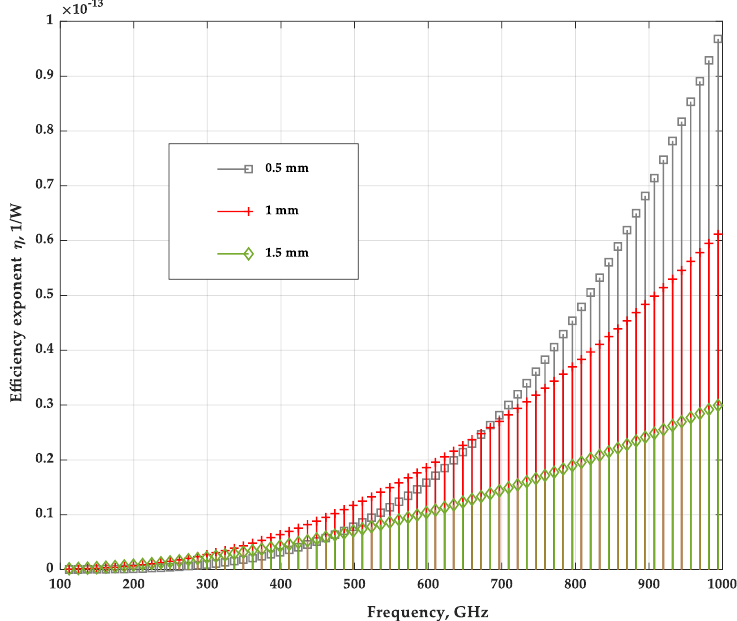
Figure 4. Dependence of the efficiency exponent η of a radio vortex beam on the difference frequency f of laser beams for three different values of the laser beam waist radius.